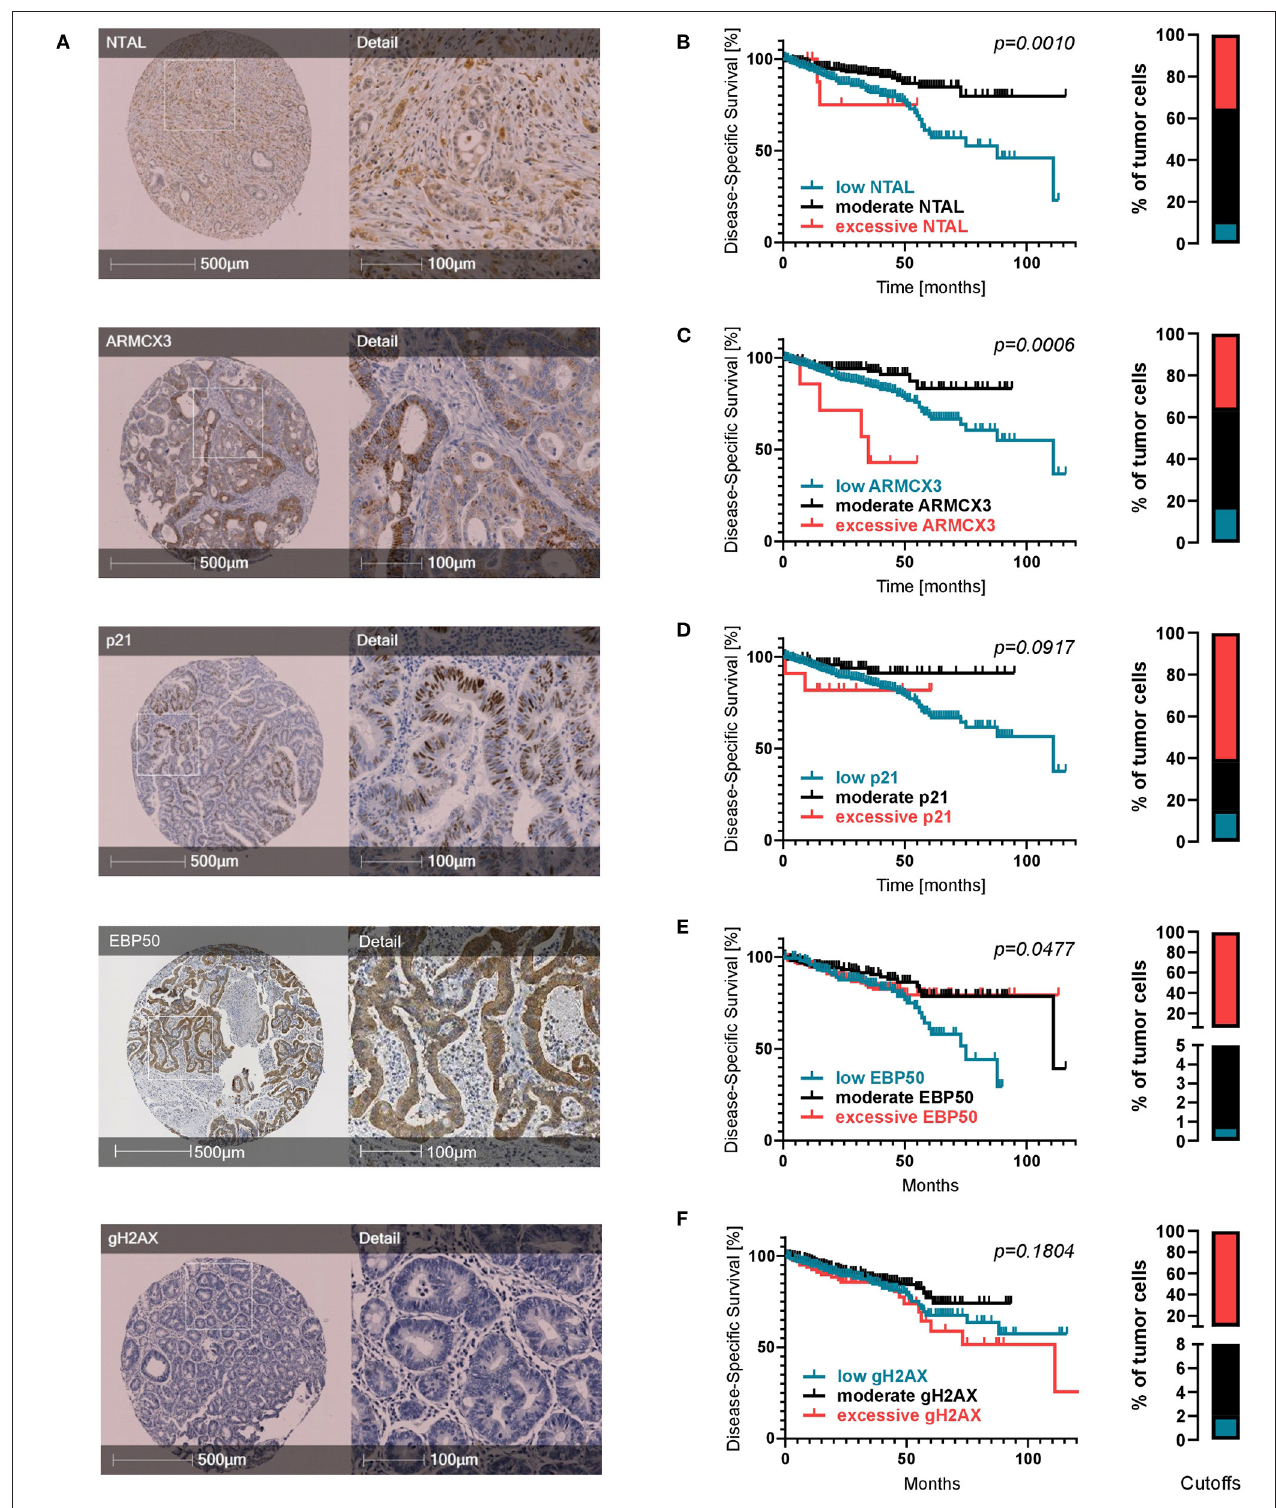
FIGURE 2 | Expression of senescence-associated molecules in CRC patients. (A) Representative TMA cores for each IHC marker. (B–F) Kaplan-Meier survival analyses regarding expression of senescence markers when divided into three subcohorts: low expression (petrol), moderate expression (black) and excessive expression (red). Cutoffs are displayed as bar graphs on the right of each curve and were calculated using a modification of the Charité Cutoff Finder from (54). Disease-specific survival is shown. Two tier subdivision, progression-free survival and detailed individual cutoff values can be found in the Supplementary Material .